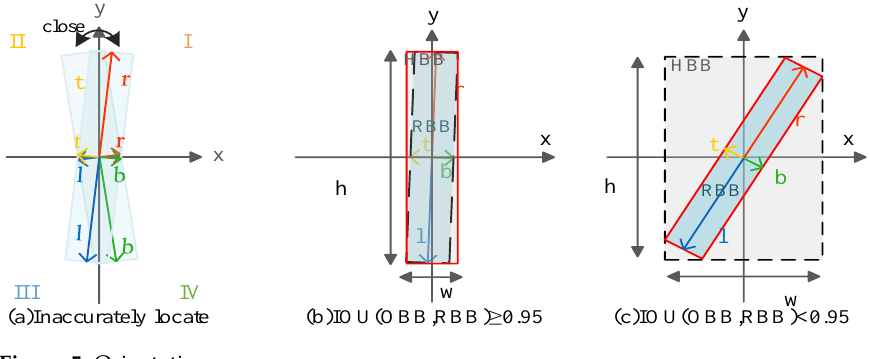
Figure 5. Orientation